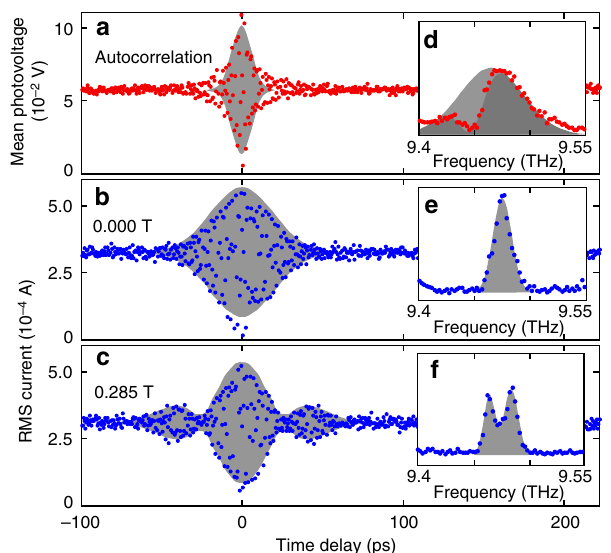
Figure 5 | Calibration of the experimental setup using a Si optical flat. Red: A reference transmission measurement of the optical flat was obtained using a high-resolution FTIR spectrometer, and multiplied by the system response (red data on Fig. 4) to give a model of the expected transmission profile of the FELIX measurement. Black: FT of the FELIX transmission interferogram for the optical flat. Good agreement is seen within the noise, which is limited by the beam-time available.